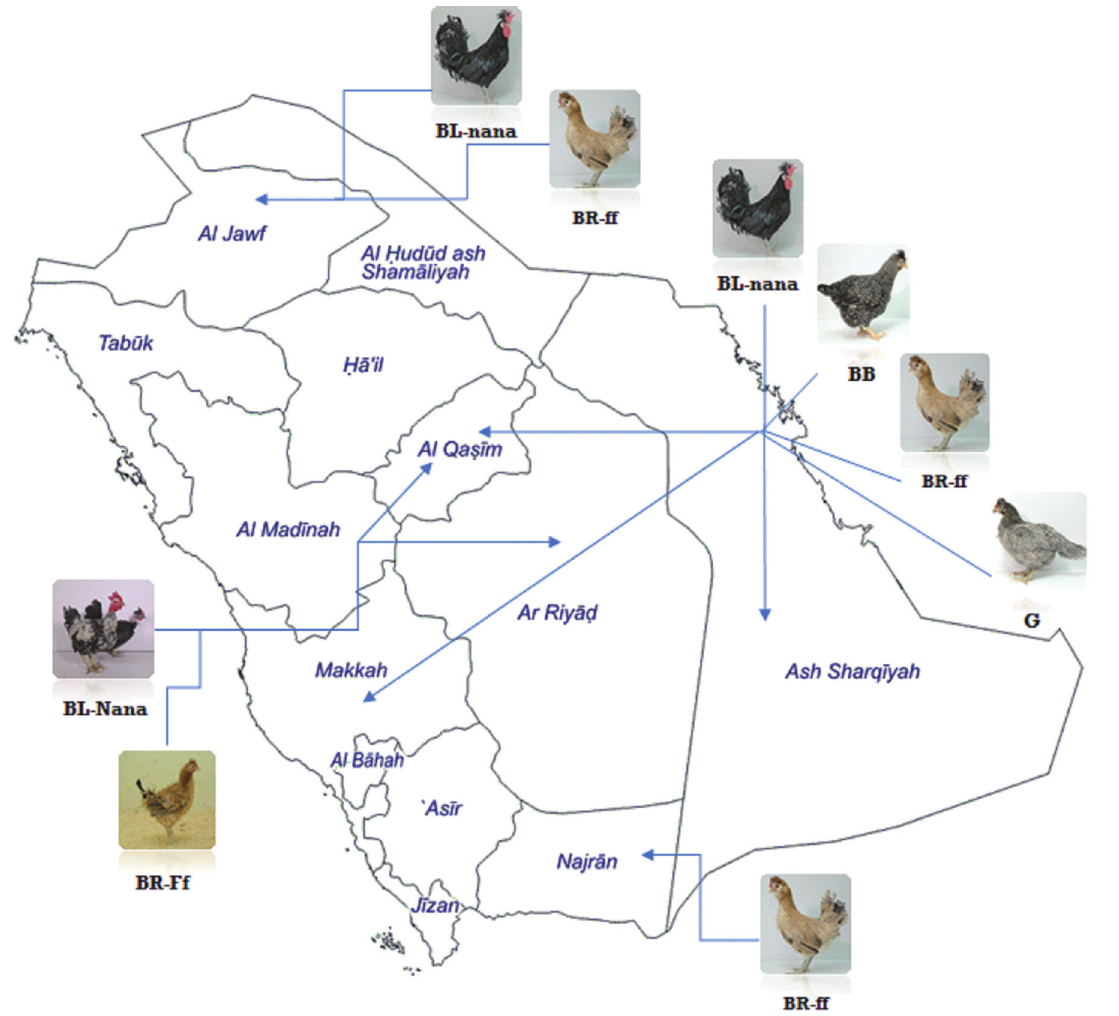
Figure 1. Geographical location of Saudi native chicken